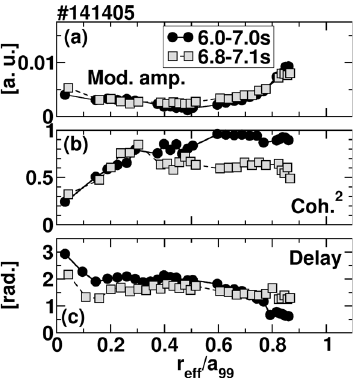
Fig.9 : Profiles similar to Fig. 6 obtained by FFT analysis of each ECE channel from 5.5 s. to 5.8 s. (circles) and from 6.8 s. to 7.1 s. (squares).